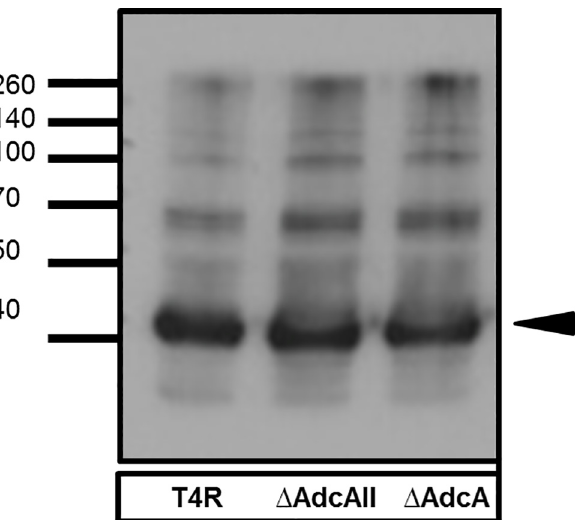
Fig 5. Western blot assessing pilus SP0463 expression. Lysates from T4R, Δ AdcA, and Δ AdcAII strains were blotted and probed with anti-SP0463 antibody and developed. Black arrow indicates SP0463 pilus